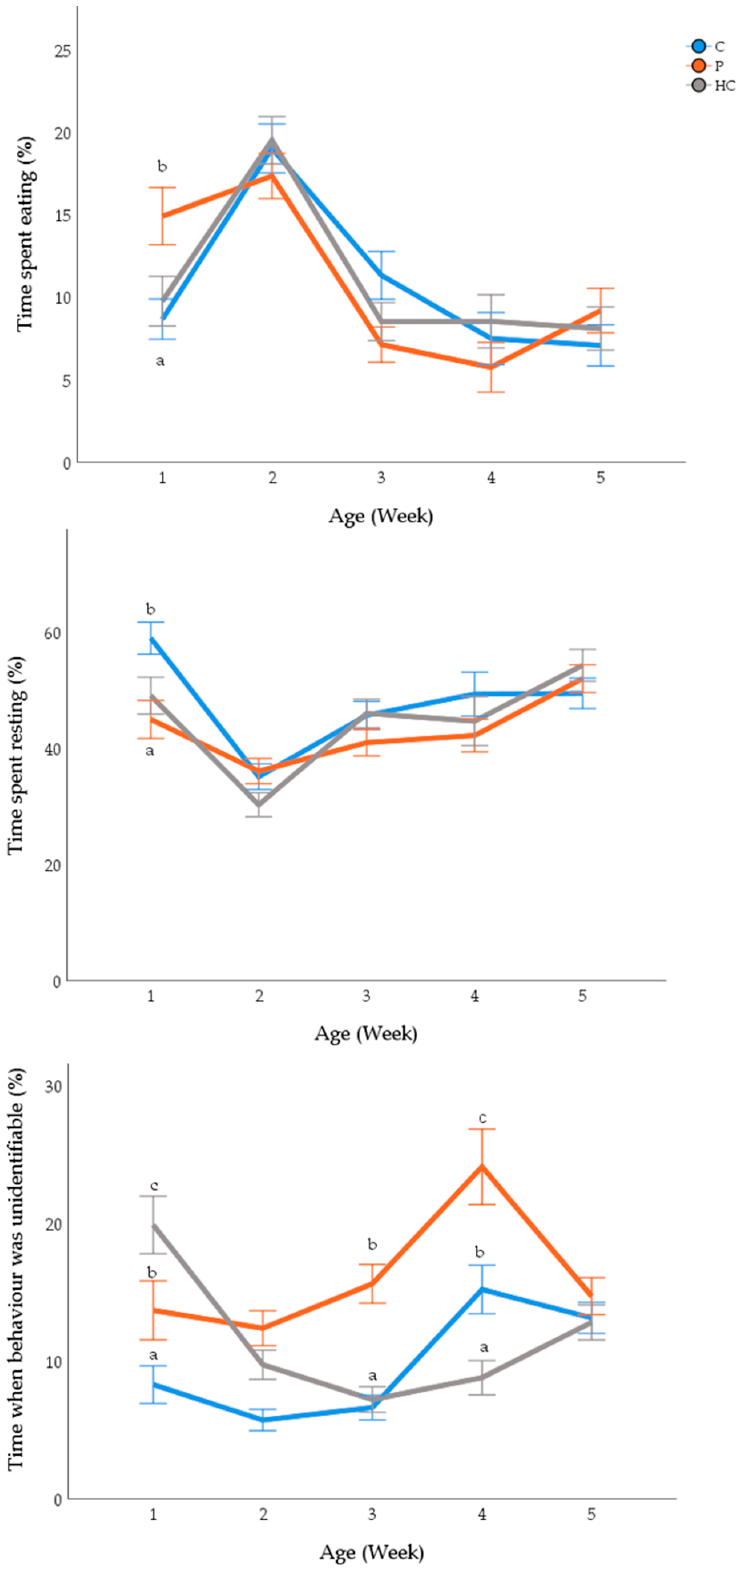
Figure 3. Mean proportion of time ( ± SEM) spent eating and resting and proportion of time that the behavior was unidentifiable from the 1st week of life to the last for birds that were raised under standard conditions (C, blue line), with additional physical items (P, grey line) or with additional human contact (HC, orange line). Differing subscript (a, b, c) denotes a treatment effect at p <